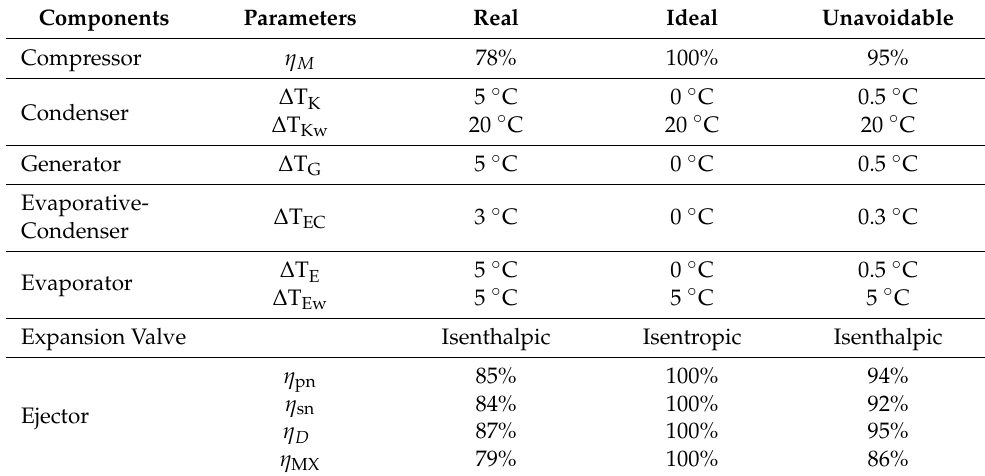
Table 1. Parameters for real, ideal, and unavoidable cycle conditions [9,20]. Components